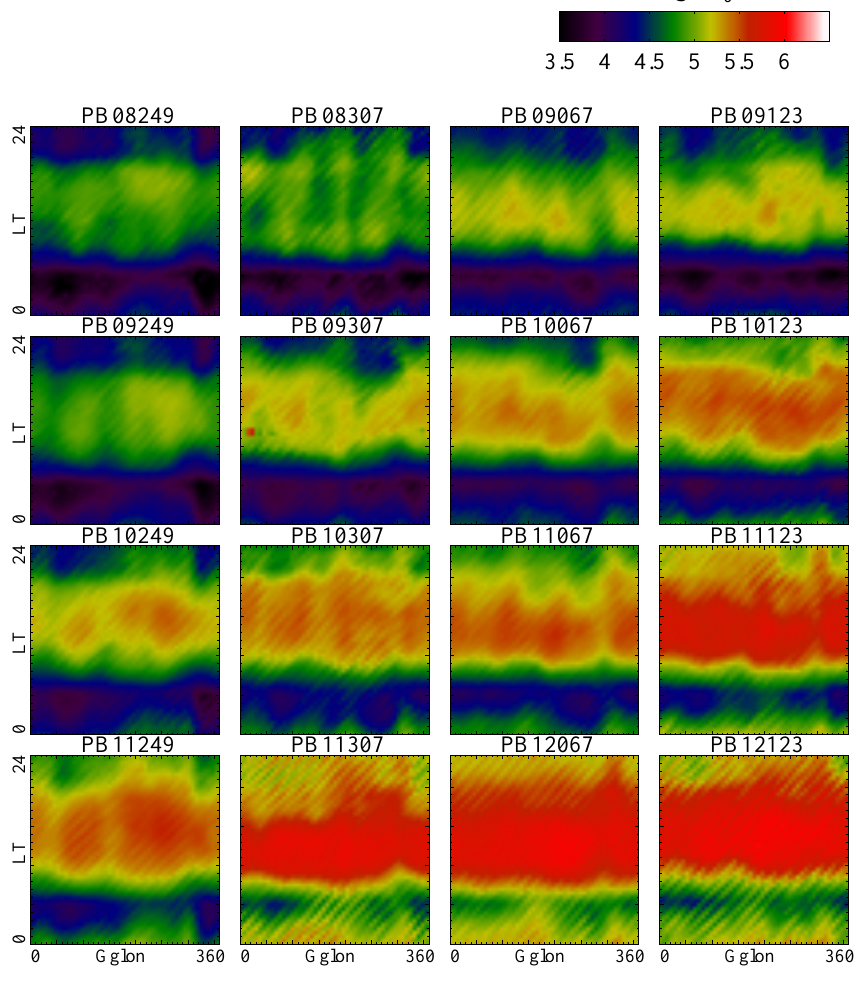
Fig. 6. Climatology of the ambient density as a function of longitude and local time, integrated over altitudes and averaged over seasons from (Northern Hemisphere) summer 2008 (upper left) to spring equinox 2012 (lower right). The density scale is logarithmic, ranging from 3 × 10 3 to 3 × 10 6 cm − 3